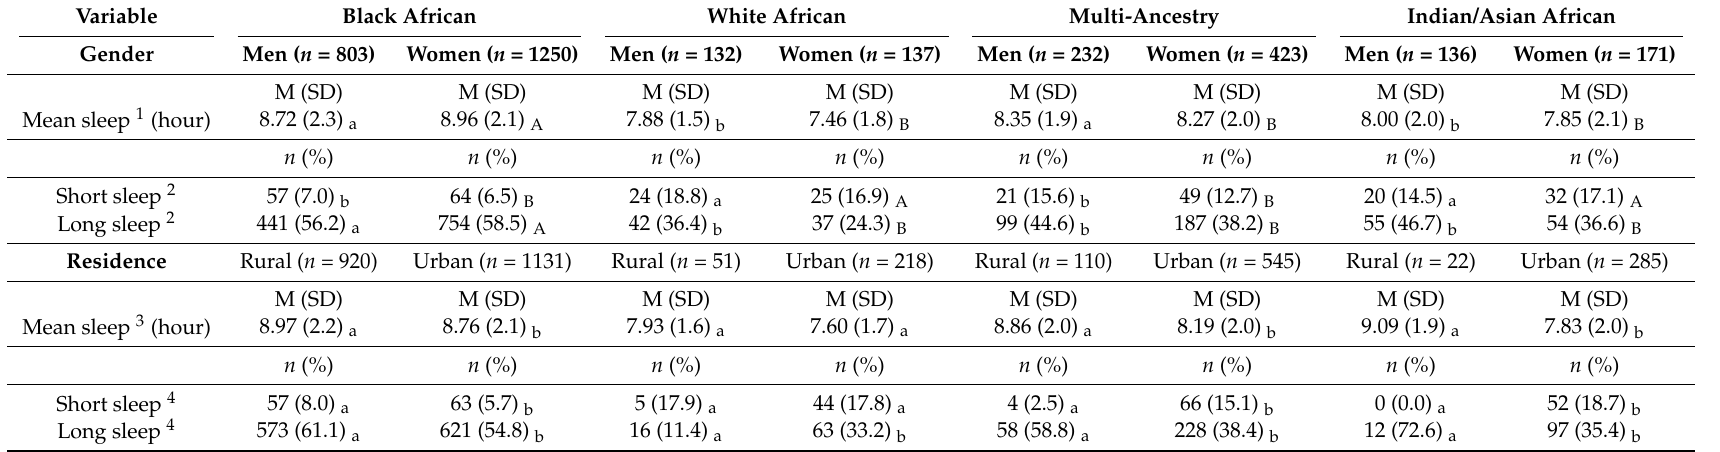
Table 2. Descriptives of sleep duration by population